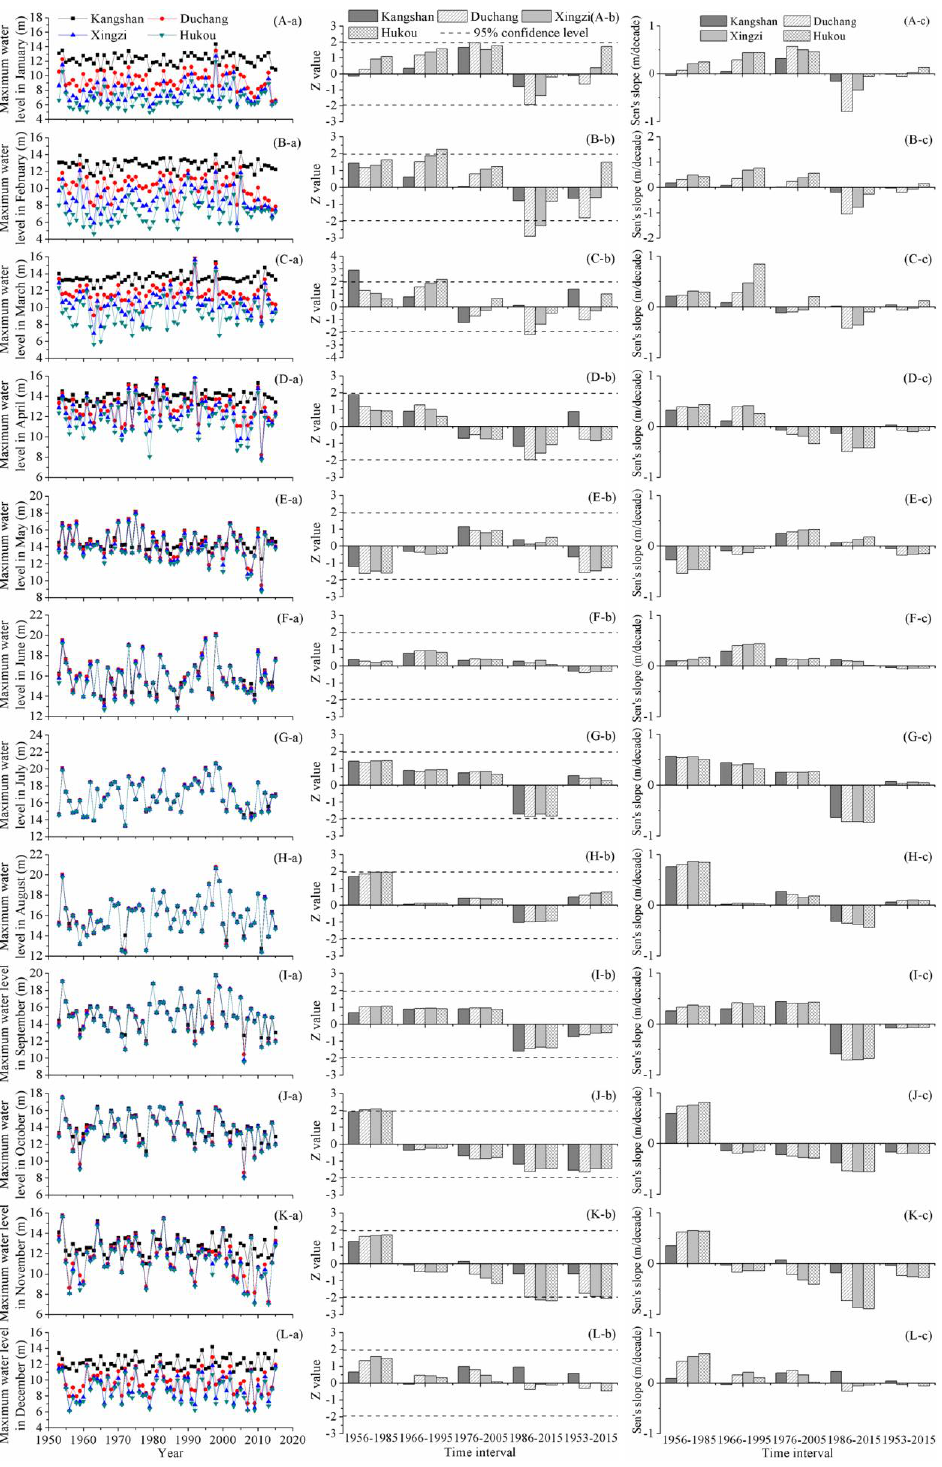
Figure 3. Change features of monthly maximum water level in Poyang Lake: (i) the sub-figures from the top to the bottom rows that are labeled (A–L) display monthly maximum water level changes in January to December; and (ii) the sub-figures from the left to the right columns that are labeled (a–c) display annual values, Z values, and Sen’s slopes, respectively.